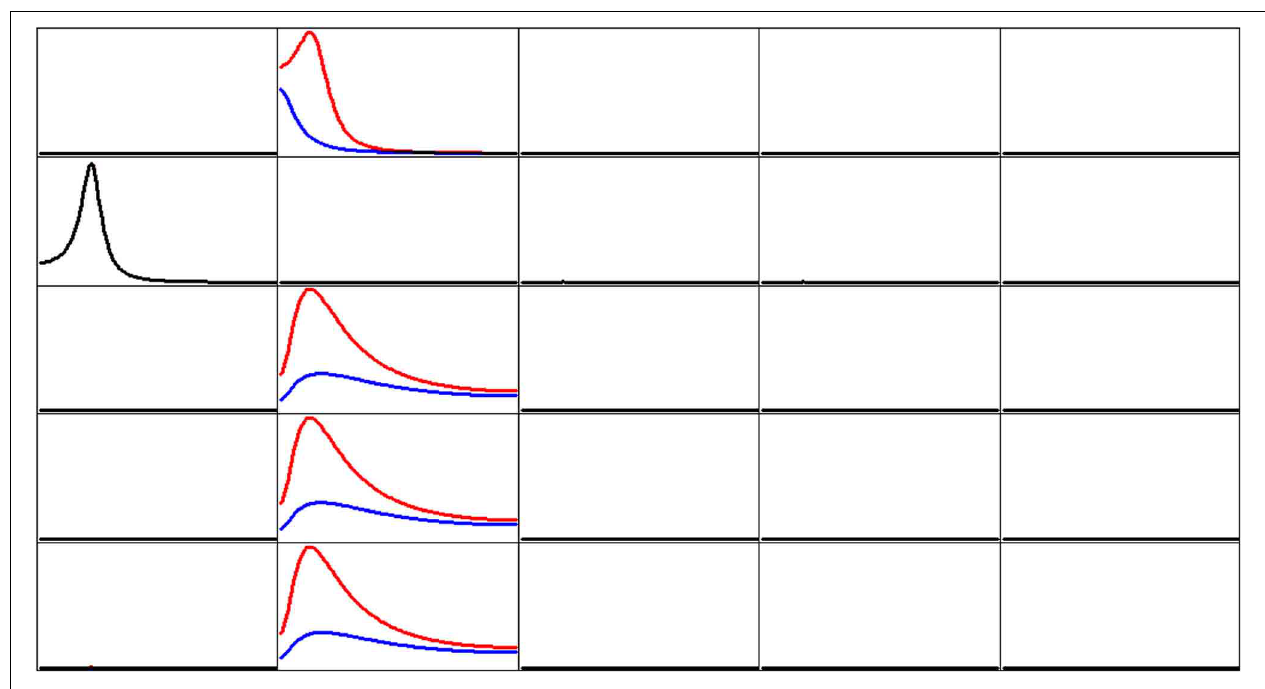
FIGURE 3 | Estimated connectivity properties for the network in Figure 1. Isolated effective coherence (iCoh) shown in RED, and the generalized partial directed coherence (gPDC) shown in BLUE. Overlap of both curves is shown in BLACK. Vertical axis: 0 to 1. Frequency axis: 1 to